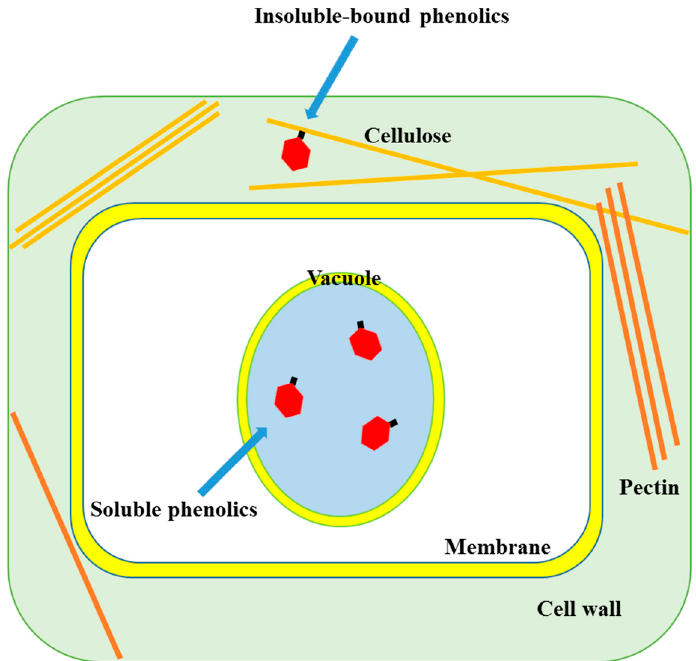
Figure 1. Localization of soluble and insoluble-bound phenolics in plant cell (other organs are not shown).